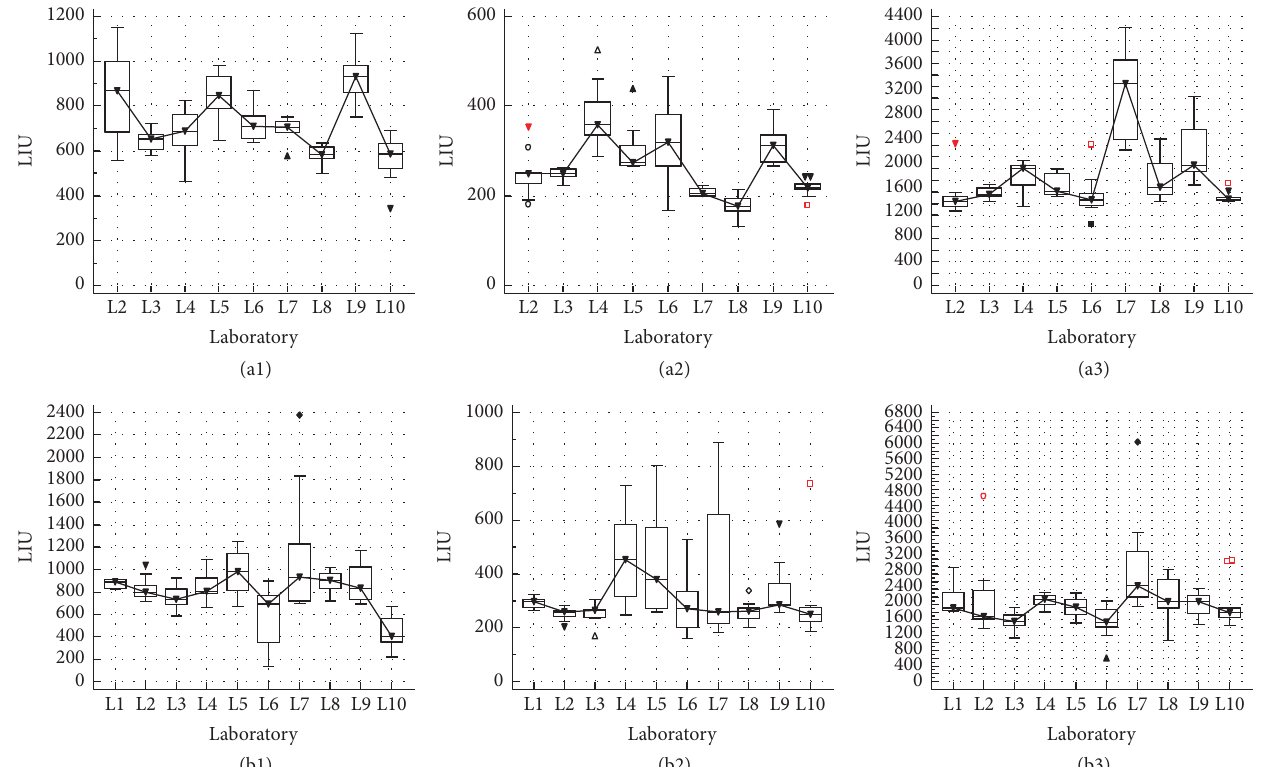
Figure 2: Results of the LIU intrarun variability for samples 1, 2, and 3 ((a1), (a2), and (a3), resp.) and LIU interrun variability for samples 1, 2, and 3 ((b1), (b2), and (b3), resp.) are shown for each individual laboratory after intervention at laboratory 6.